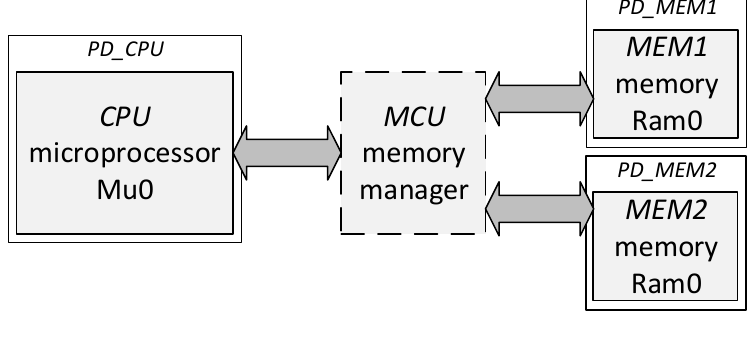
Figure 3. The case-study system abstract architecture